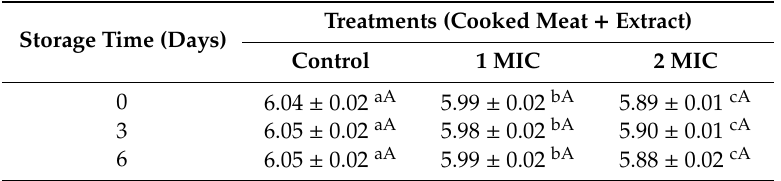
Figure 7. Antibacterial effect of ATCE on S. aureus ATCC 13565 inoculated into sterile lean cooked pork during storage. Values denote the means of triplicate measurements. Error bars represent standard deviation ( n = 3). Different letters represent significant differences ( p < 0.05).